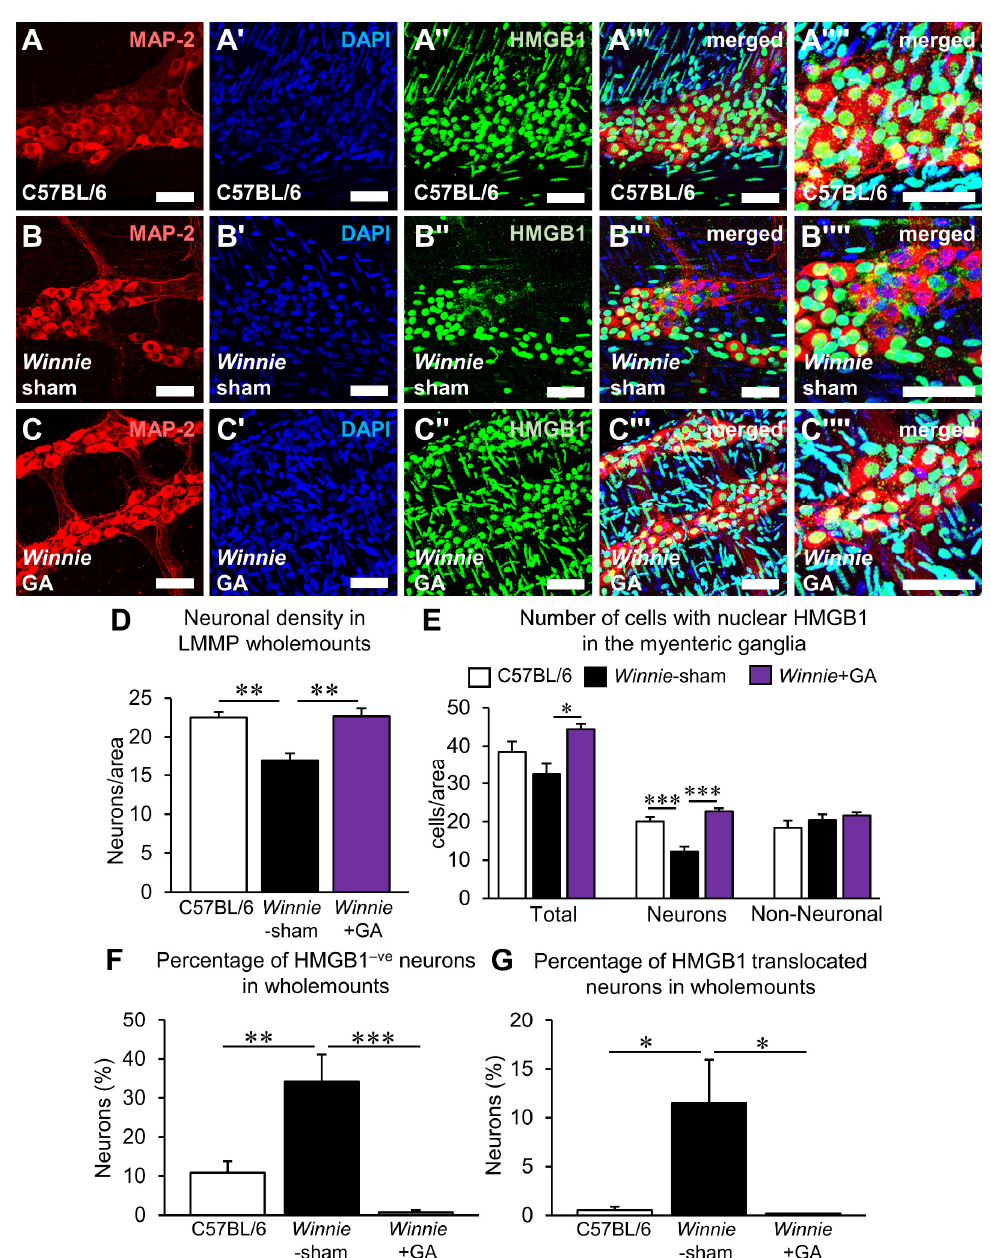
Figure 7. Effects of glycyrrhizic acid treatment on neuronal HMGB1 expression in wholemount LMMP preparations from the distal colon of Winnie mice. ( A – C’’’’ ) HMGB1 in neurons within the myenteric ganglia were observed by immunofluorescence of the neuronal marker MAP-2 ( A – C ), the nuclear stain DAPI ( A’ – C’ ), HMGB1 ( A’’ – C’’ ), merged images ( A’’’ – C’’’ ) and merged magnified images ( A’’’’ – C’’’’ ) in LMMP wholemount preparations from the distal colon of C57BL/6 mice ( A – A’’’’ ), sham-treated Winnie mice ( B – B’’’’ ) and Winnie mice treated with glycyrrhizic acid (GA) ( C – C’’’’ ) (scale bar = 50 µm). ( D ) Quantification of myenteric neuronal density expressed as the number of neurons per ganglionated area. ** p < 0.01; n = 6 animals/group. ( E ) The total number of cells, neurons and non-neuronal cells with nuclear HMGB1 within the ganglia expressed as cells per gan- glionated area. ( F ) Percentage of neurons without HMGB1 in the nucleus. ( G ) Percentage of neurons with HMGB1 translocated to the cytoplasm. * p < 0.05, ** p < 0.01, *** p < 0.001; n = 5 animals/group. The effects of HMGB1 inhibition on plexitis in the myenteric ganglia of Winnie mice were evaluated to determine whether the chemotactic properties of HMGB1 on leukocytes could explain its effects on neuronal loss. Leukocytes visualised by anti-CD45 antibody in